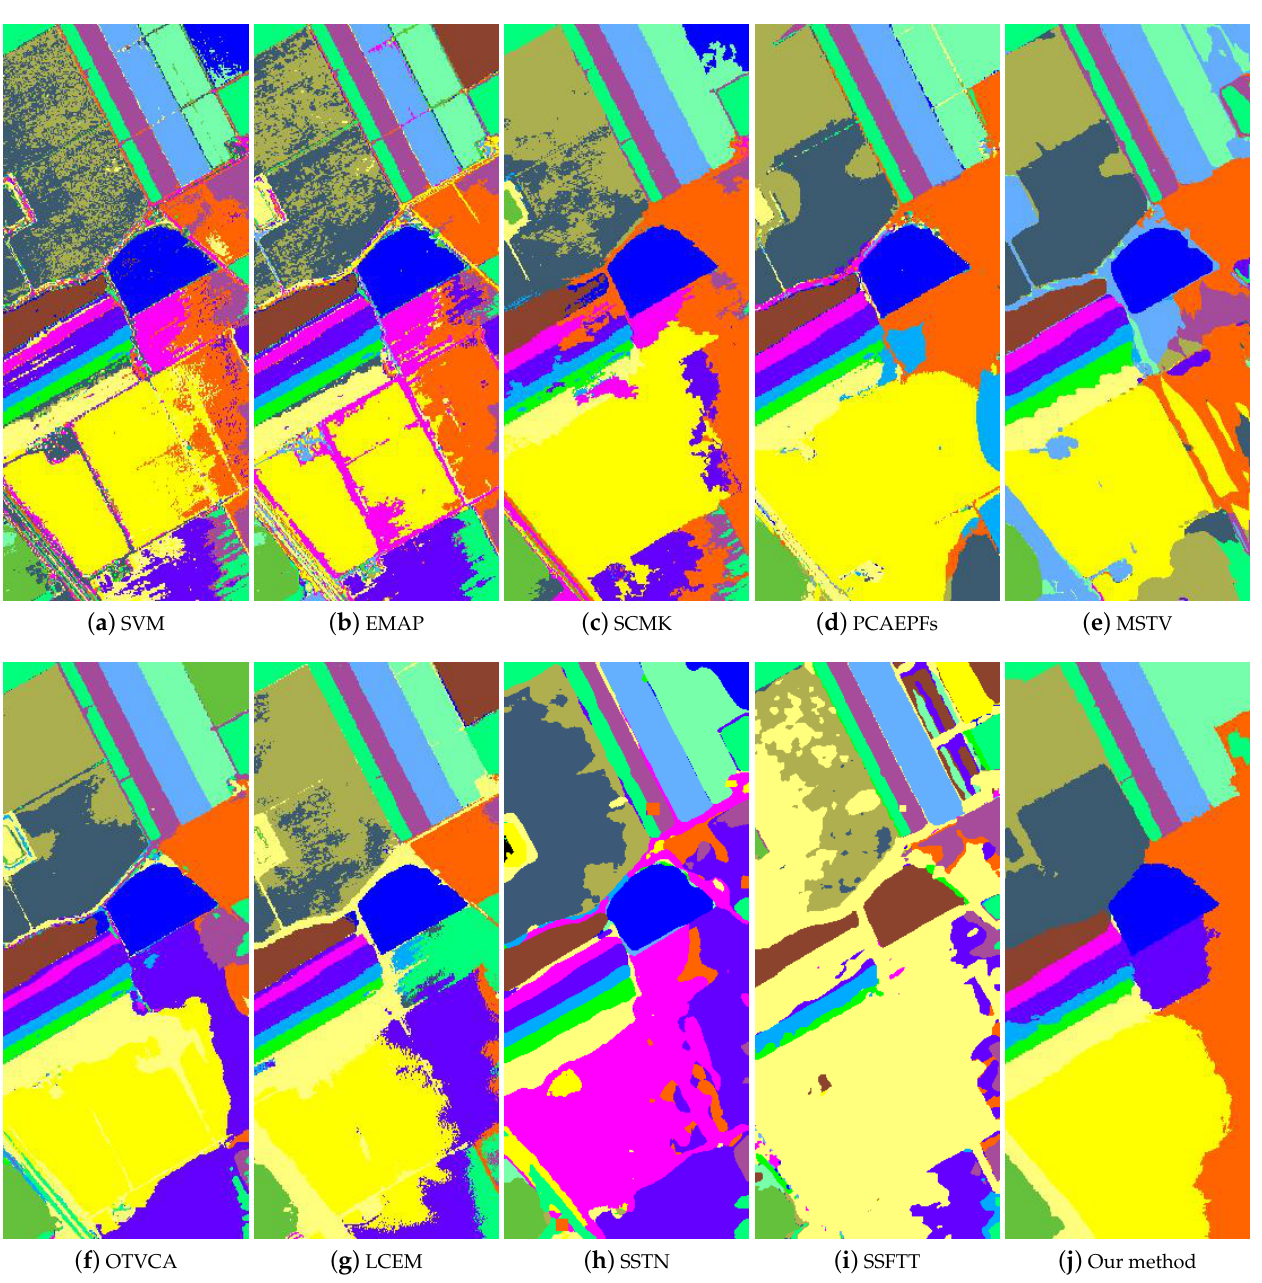
Figure 5. Classification maps of different classification methods on the Salinas dataset. ( a ) SVM [11], OA = 80.08%. ( b ) EMAP [38], OA = 85.54%. ( c ) SCMK [39], OA = 88.70%. ( d ) PCAEPFs [40], OA = 95.12%. ( e ) MSTV [6], OA = 94.46%. ( f ) OTVCA [41], OA = 93.04%. ( g ) LCEM [42], OA = 90.15%. ( h ) SSTN, OA= 69.67%, ( i ) SSFTT, OA= 39.93%, ( j ) Our method, OA =